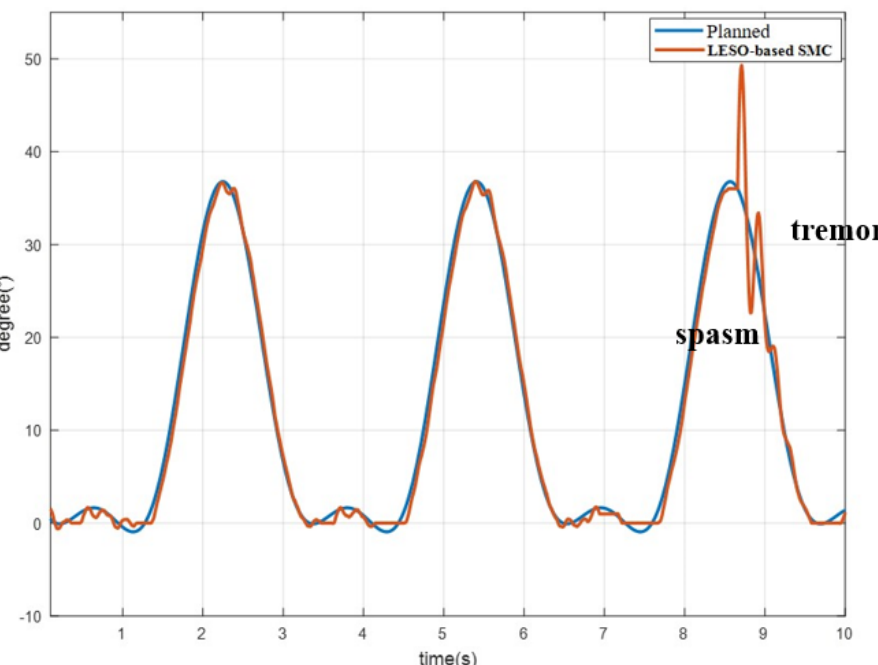
Figure 13. Trajectories of hip joint by LESO-based SMC with spasm and tremor occurring at walking speed = 0.15 m/s.